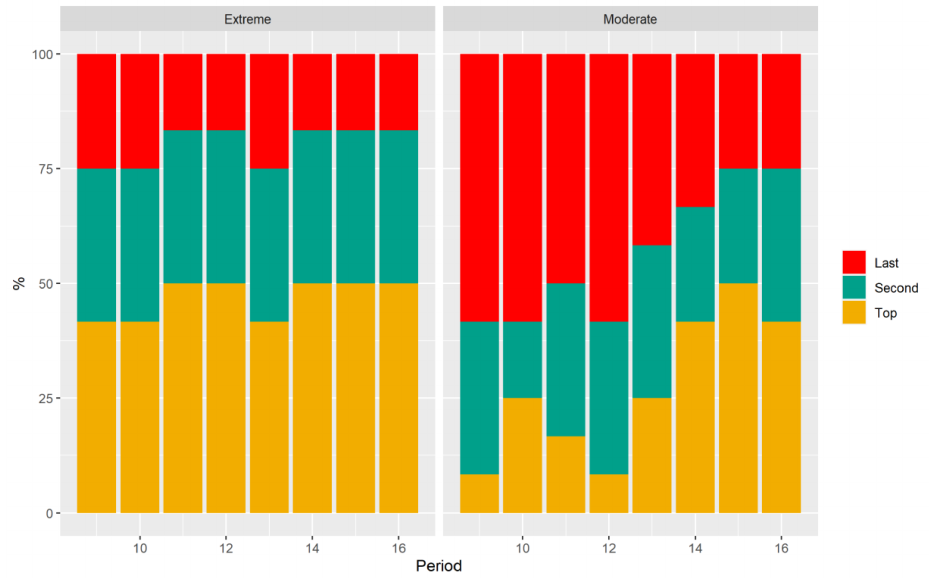
Figure 4. Centrist’s election